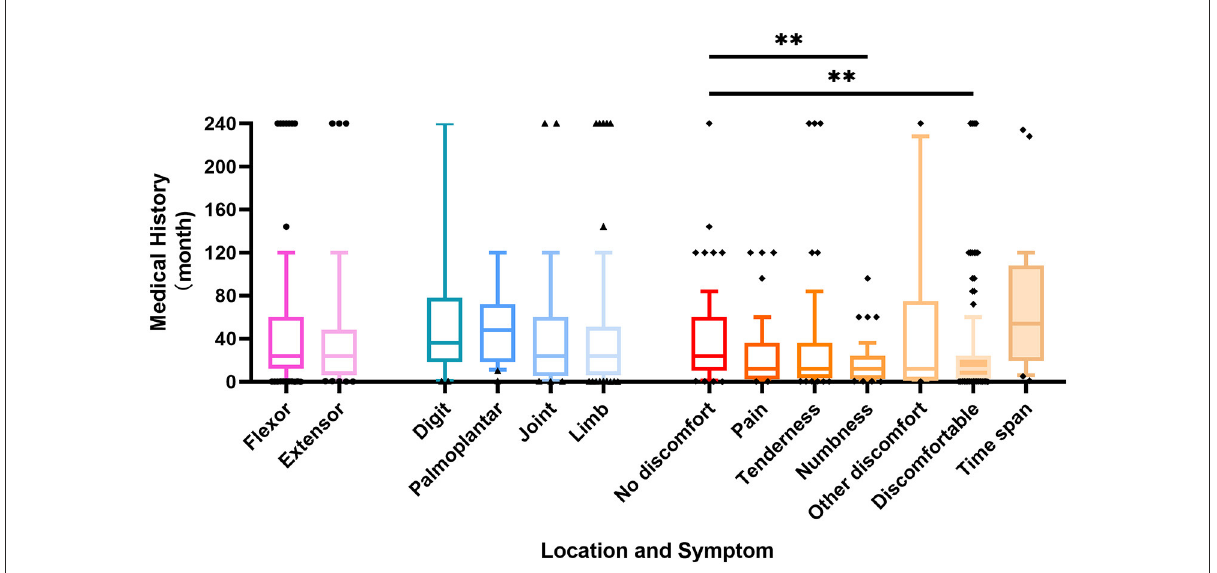
FIGURE1 Box plot representing the correlation between patient history time and schwannomas location and symptoms. p -value ** <